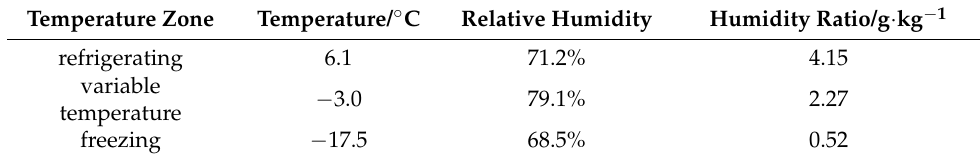
Table 1. Measured temperature and humidity of the return air from all